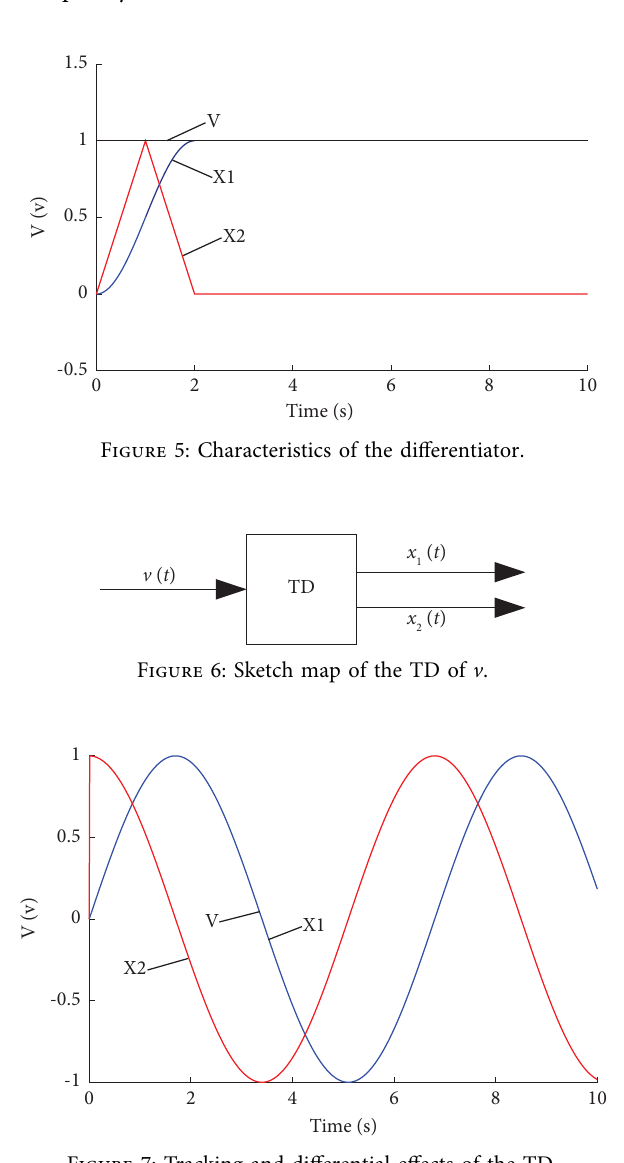
Figure 7: Tracking and diferential efects of the